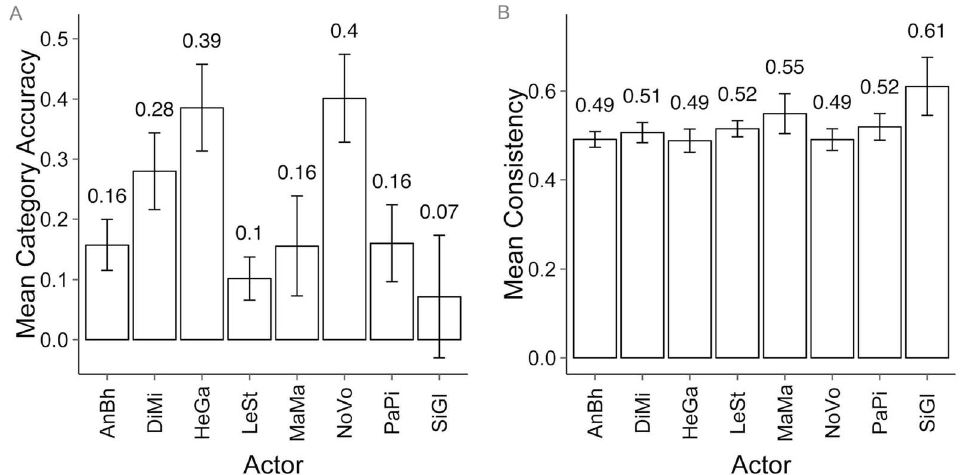
Figure 6. Average recognition accuracy across actors (A) and observers’ response consistency across actors (B). All error bars represent 95%